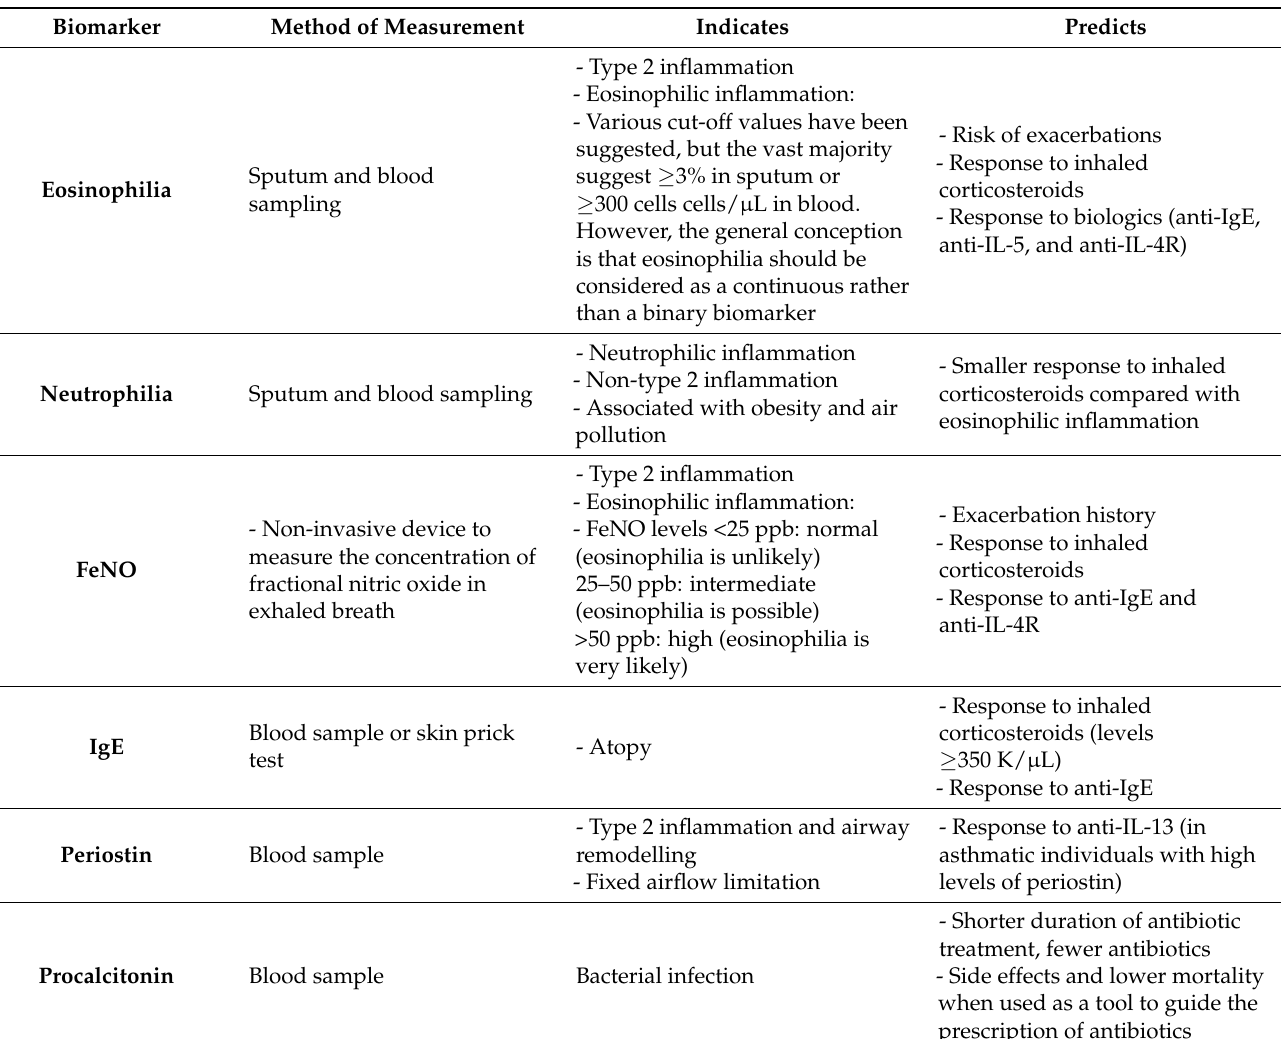
Table 1. Summary table of biomarkers in asthma and